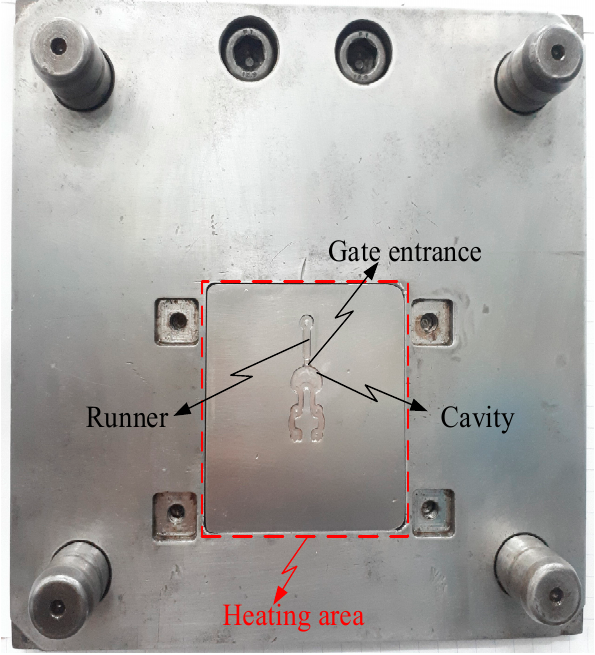
Figure 16. The mold for the front cover part with the gate heating area.